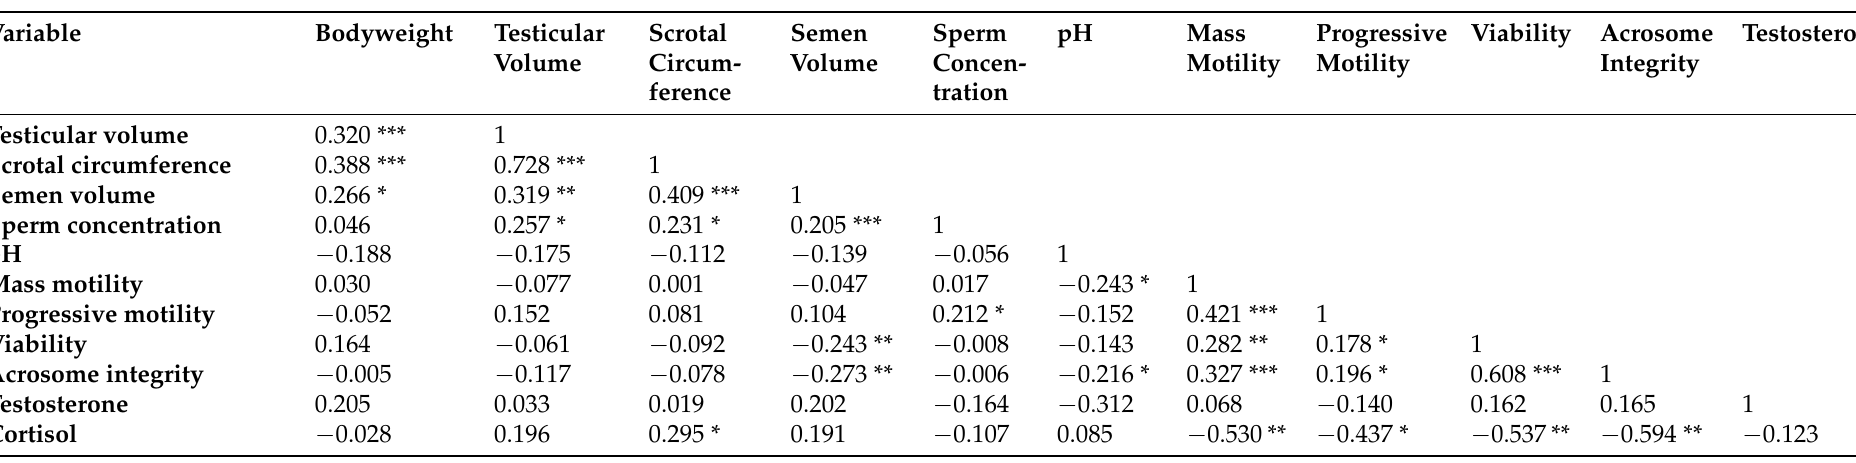
Table 5. Pearson’s Correlation Coefficient between weight, some testicular measurements, semen quality, and hormonal status variables in the